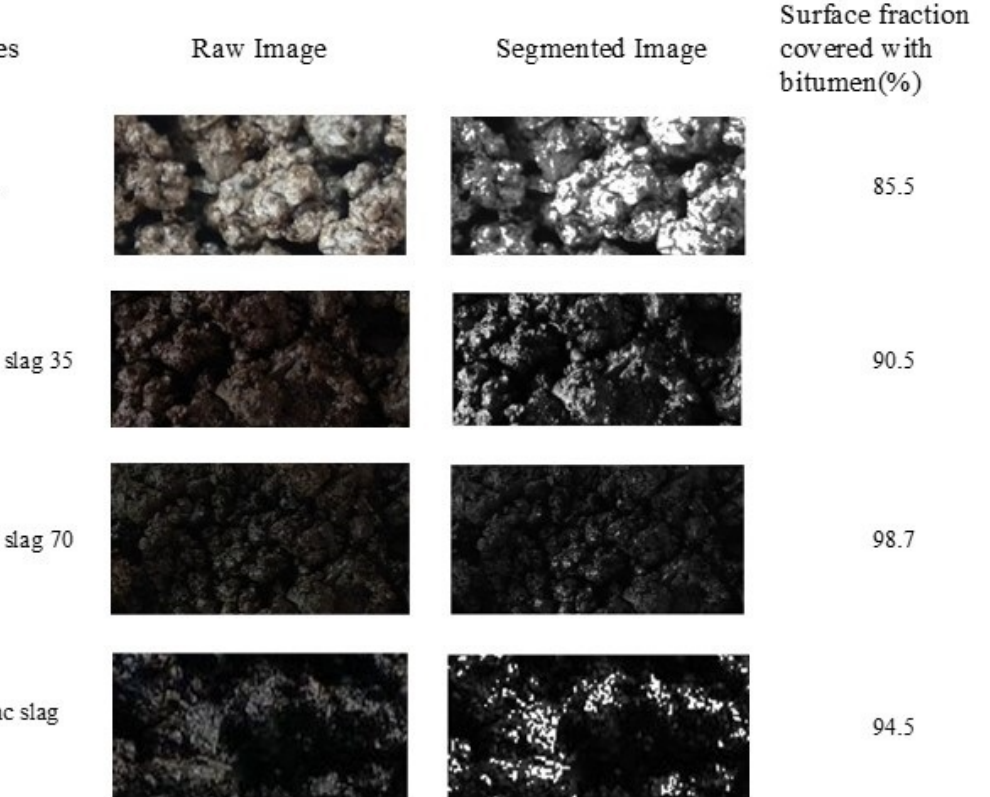
Figure 6. The results of the image analysis of Boiling Test samples.